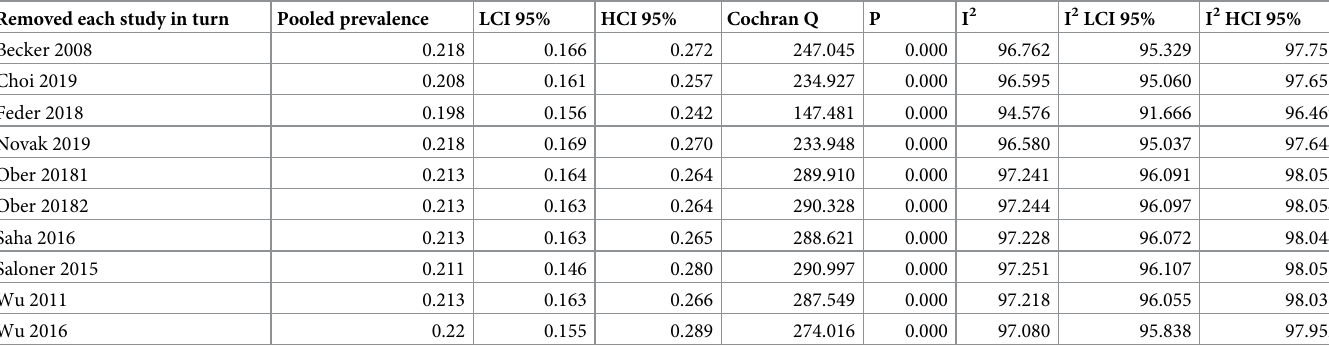
Table 2. 12-month OUD treatment seeking IVhet base model metaXL sensitivity. Removed each study in turn Pooled